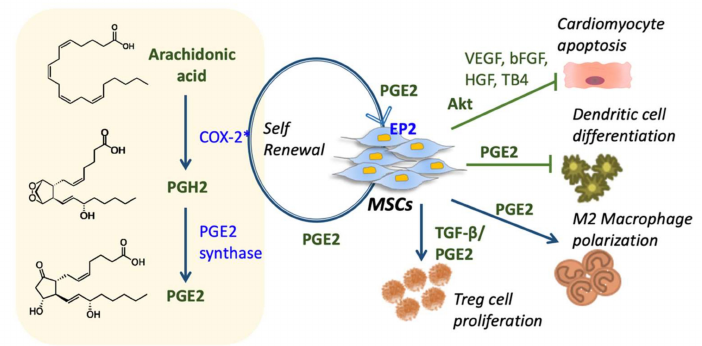
Figure 2. The autocrine and paracrine functions of MSC. The left side depicts the cyclooxygenase-2 (COX-2) / prostaglandin E2 (PGE2) axis for the maintenance of an autocrine / paracrine loop and COX-2 mediated PGE2 production in MSCs as a response to the surrounding microenvironment. The right side of the figure demonstrates the dominance of MSCs on immune cells (inhibiting cardiomyocyte apoptosis and DC di ff erentiation, also promoting M2 macrophage polarization and T-reg cell proliferation) by producing several immunomodulatory factors and chemokines. Note: Figure represents both conditioned / modified and natural